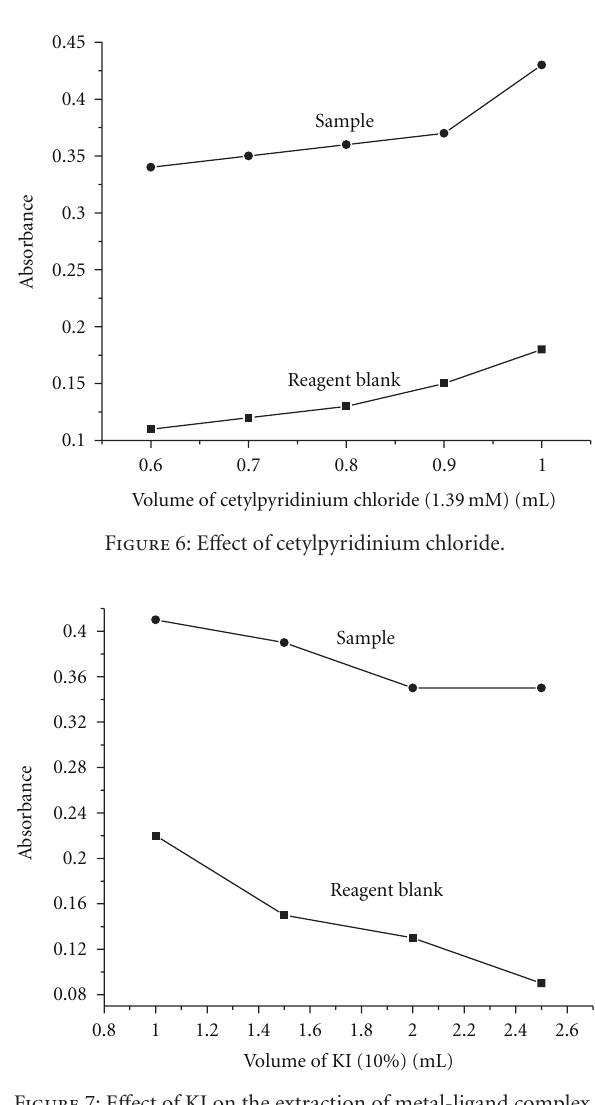
Figure 7: E ff ect of KI on the extraction of metal-ligand